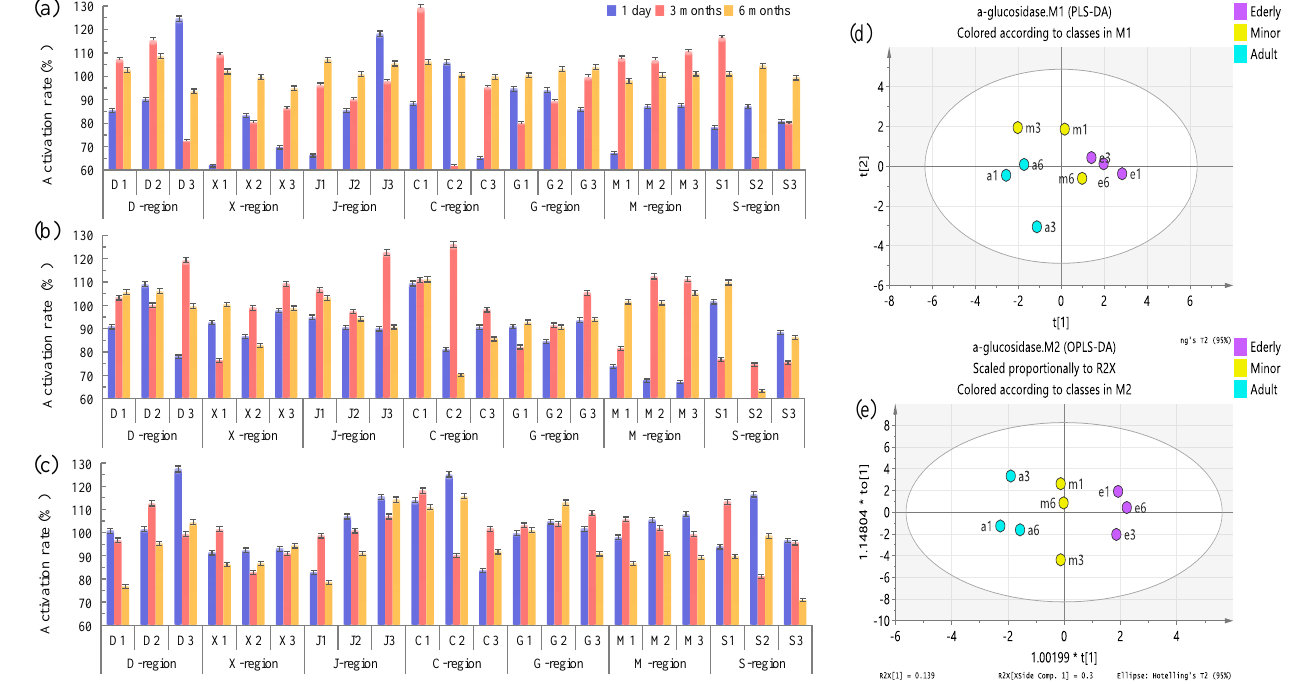
Figure 7. Inhibition rate of COF condensates on α -glucosidase for minors ( a ), adults ( b ), and the elderly ( c ), and their PLS-DA ( d ) and OP LS-DA ( e ) diagrams. Briefly, in the minor group, 47.6% of the results showed that the inhibition of α -glu-